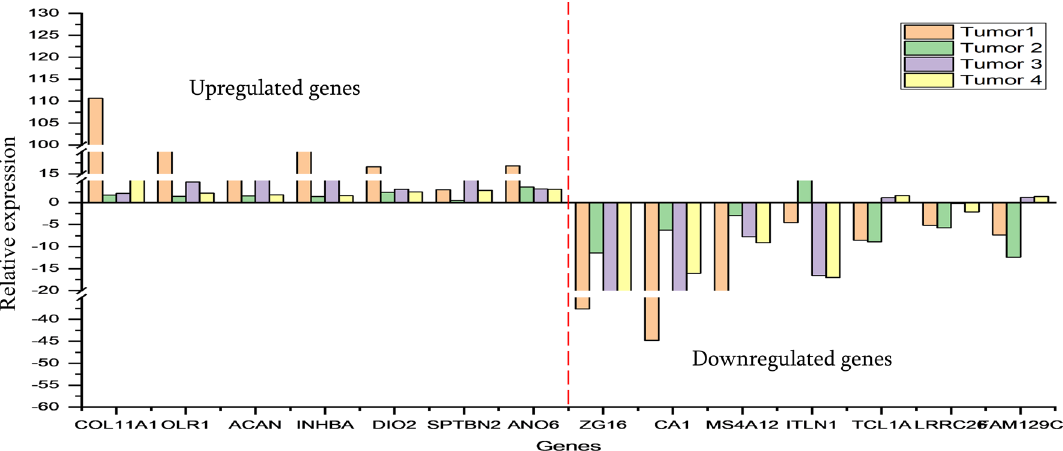
Figure 2. QRT-PCR analysis of upregulated and down regulated DEGs from RNA-Seq data analysis. The left panel of genes represents up regulated DEGs and the right panel of genes represents downregulated